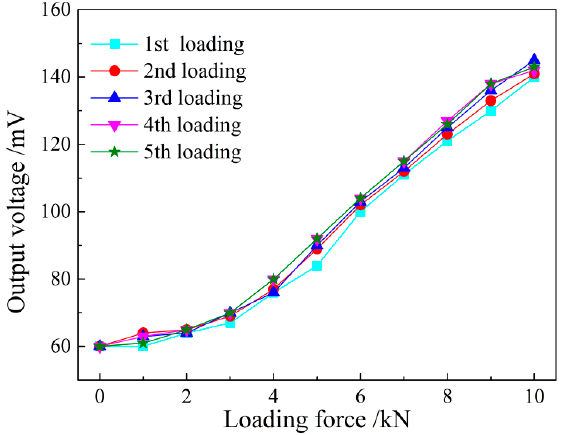
Figure 15. The output voltage with loaded stress with magnetic shielding.